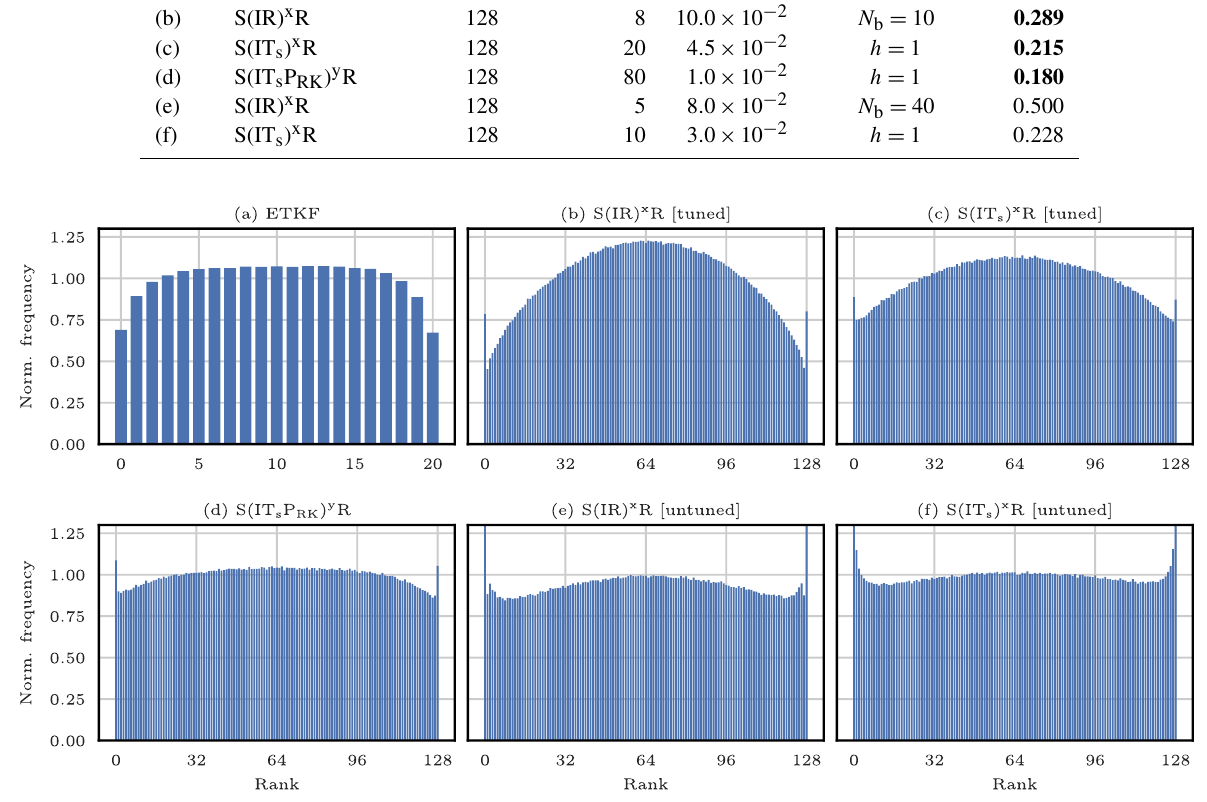
Figure D1. Rank histograms for the selection of algorithms detailed in Table D1. The frequency is normalised by N e + 1 (the number of